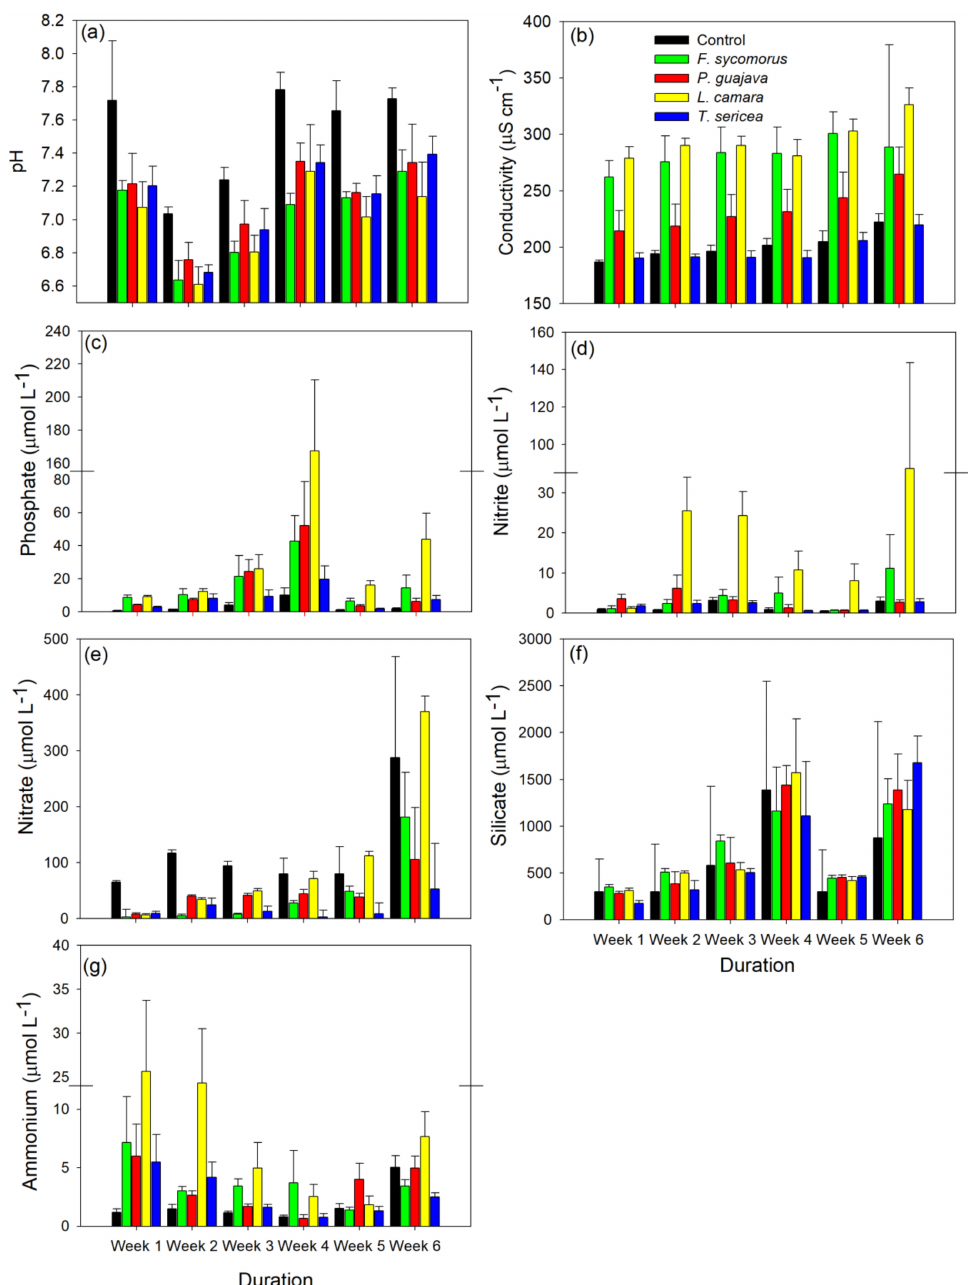
Figure 2. Nutrient release concentrations (i.e., amount present in waterbody) ( + standard deviation) of invasive Lantana camara (yellow) and Psidium guajava (red), and native Terminalia sericea (blue) and Ficus sycomorus (green), over a 6-week period: ( a ) pH, ( b ) conductivity, ( c ) phosphates, ( d ) nitrite, ( e ) nitrate, ( f ) silicate, and ( g )